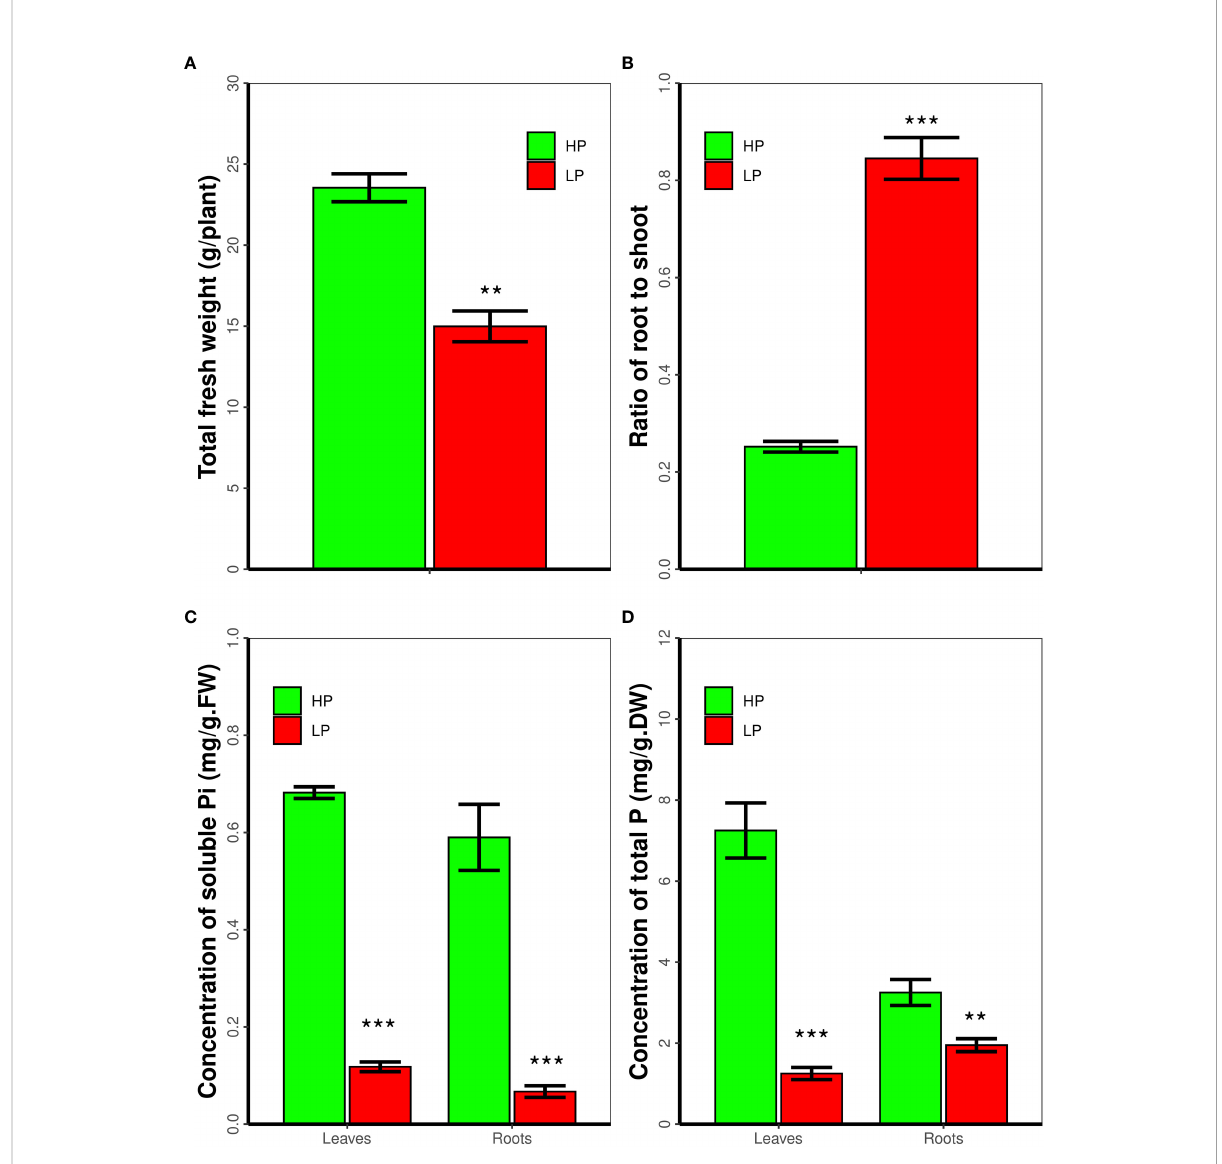
FIGURE 1 Low P stress inhibits soybean seedling growth and decreases the concentration of soluble Pi and total P. Seven-day-old soybean seedling were subjected to low P stress for 14 day. The Fresh weight of roots and shoots, the ratio of root to shoot, and the concentration of soluble phosphorus and total phosphorus was measured. Results are means ± SE from three independent experiments. Students ’ t -test was used to compare difference. **P < 0.01; ***P <